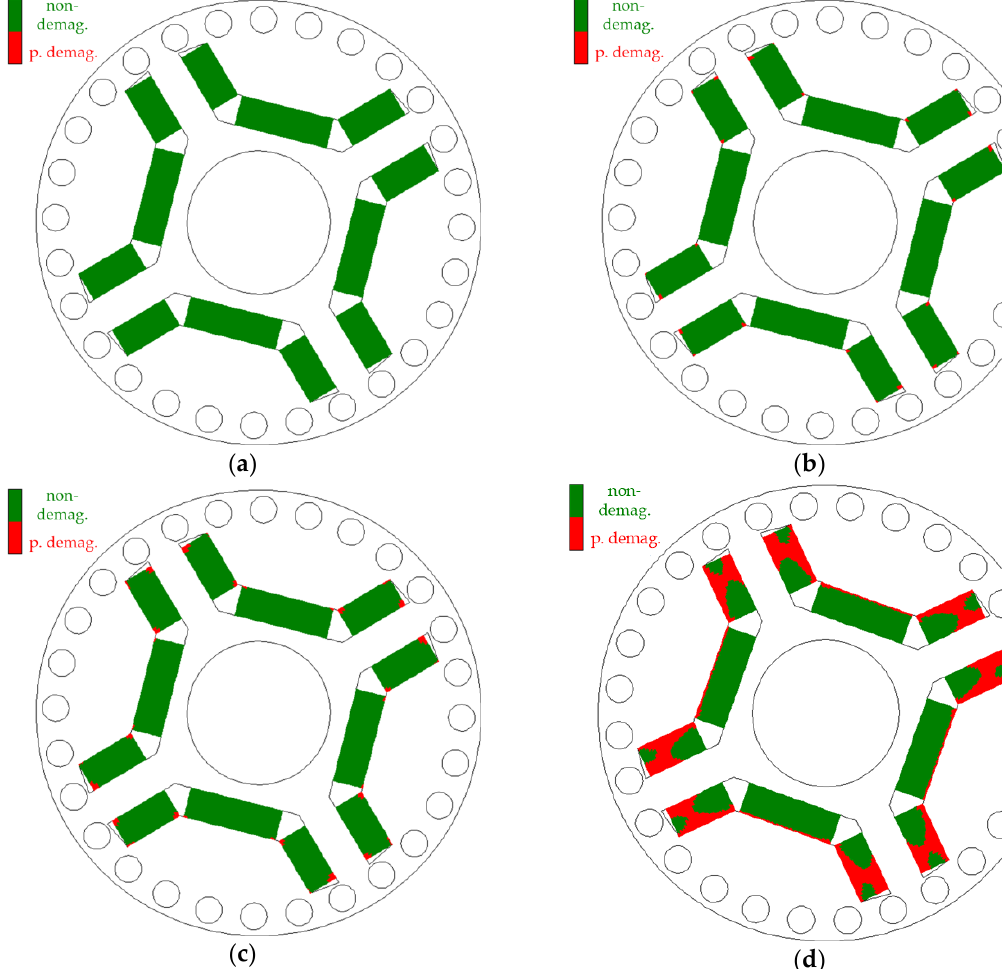
Figure 17. Visualization of non-demagnetized (non-demag.) and partially demagnetized (p. demag.) sub-areas of permanent magnets after start-up for t = 0.6 s, T L = 19.5 Nm, J i = 0.0082 kgm 2 : ( a ) τ i = 26 ° C,